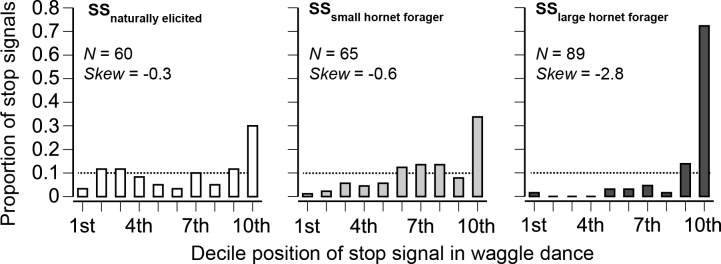
Effect of stop signals (SS) elicited by unknown natural causes, the small hornet, and the large hornet upon waggle dancing (dances performed by 51, 58, and 51 different bees from three colonies; the number of stop signals is shown in each plot).The effect of naturally elicited stop signals was observed with bees waggle dancing for natural food sources. All other dances were from bees trained to a feeder, none of which directly experienced the predator. If stop signals had no effect upon waggle dancing, they would be uniformly distributed (shown by a dashed line). However, all distributions are significantly different from a uniform distribution (p << 0.00001). As the efficacy of the inhibitory signal increases, the distributions should become more negatively skewed. A stop signal that always immediately stops waggle dancing would have only a single bar at the tenth decile. Stop signals produced by foragers attacked by the large hornet (SS large hornet forager) were significantly more inhibitory (p << 0.00001) than those elicited by the small hornet (SS small hornet forager).